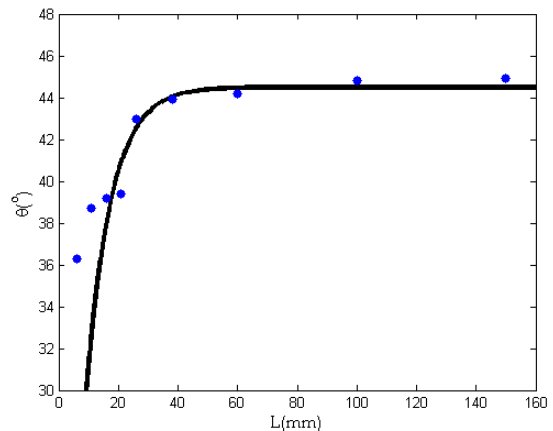
Figure 5. The relationship between needle length and crystallinity. Dots are experimental data; the continuous line is the theoretical prediction.